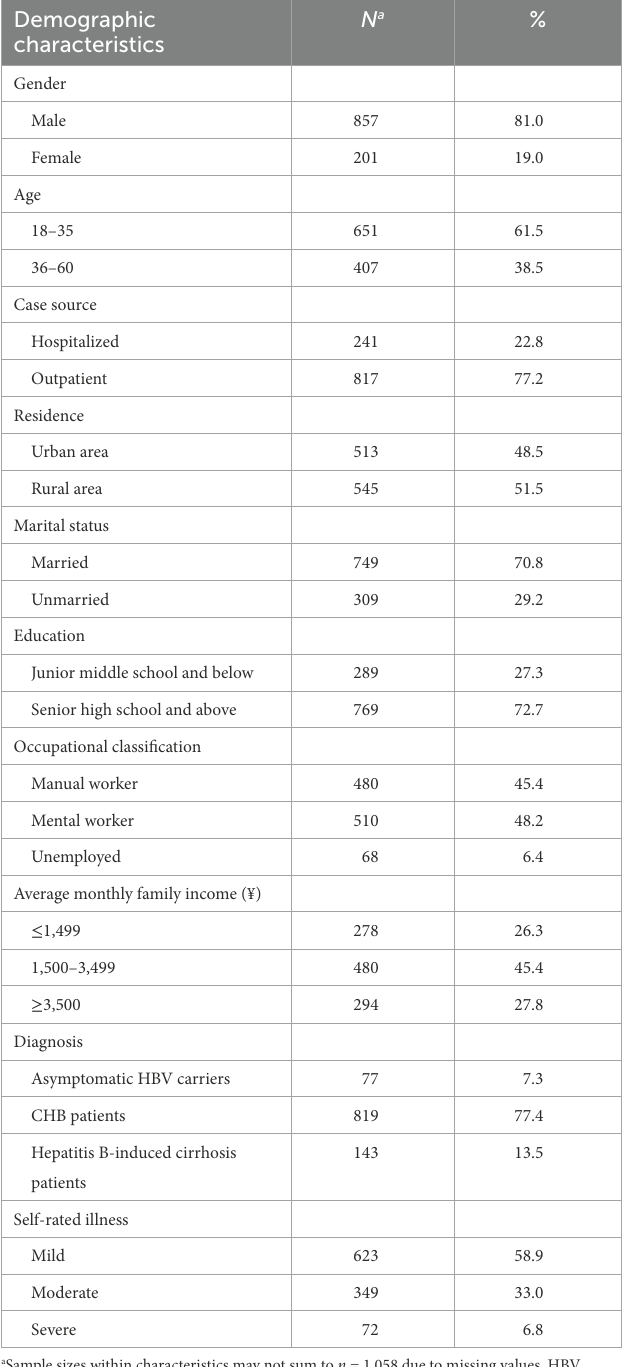
TABLE 2 Participants’ demographic and disease characteristics ( n =